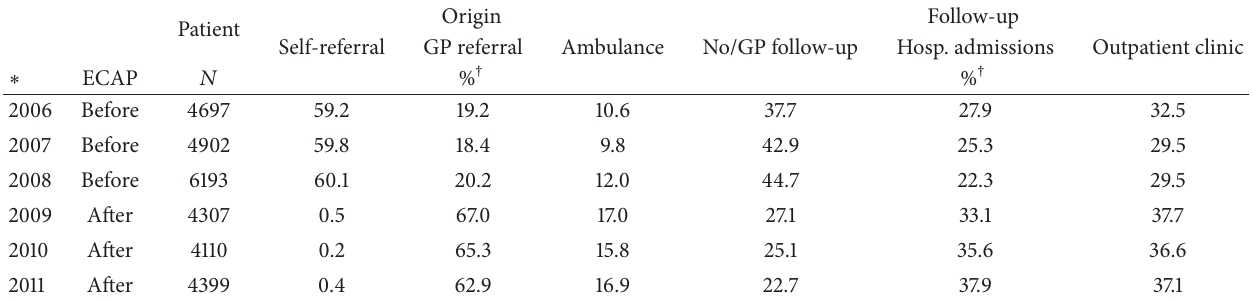
Table 2: Effect of the closure of another city’s ED on patient numbers and percentage on the researched ED.